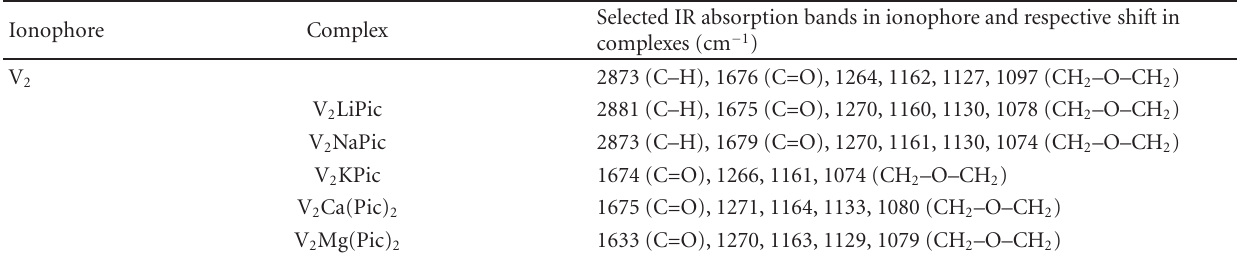
Table 2: IR spectral data of alkali and alkaline earth metal complexes with ionophore V 2 . Selected IR absorption bands in ionophore and respective shift in Ionophore Complex complexes (cm − 1 ) 2873 (C–H), 1676 (C = O), 1264, 1162, 1127, 1097 (CH 2 –O–CH 2